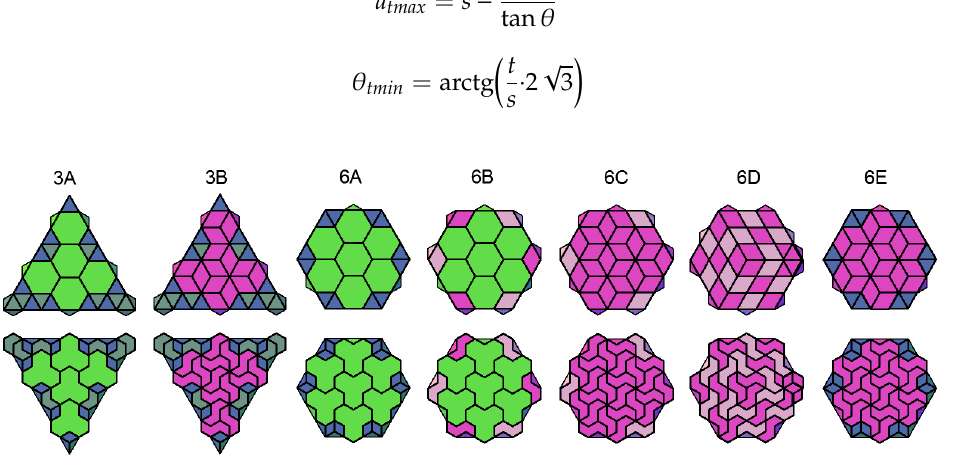
Figure 15. Triangular and hexagonal slab structures inspired by Frezier blocks.